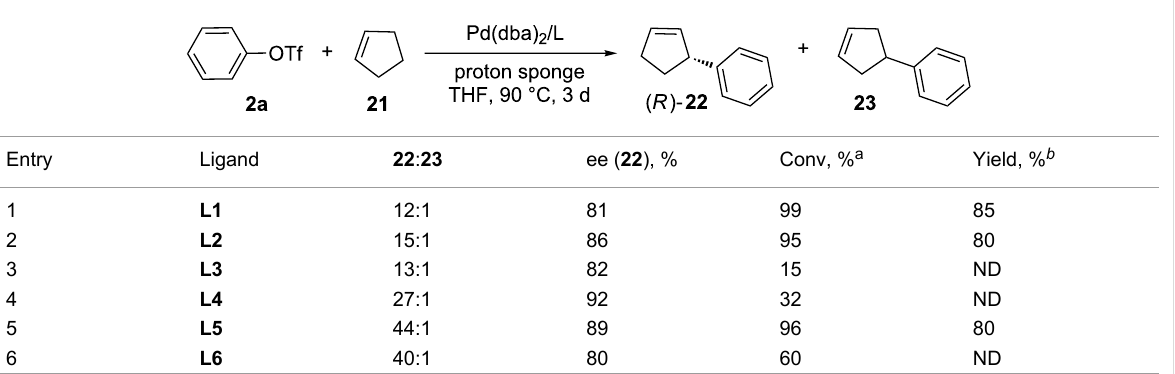
Table 5: Evaluation of Ligands L1 – L6 in the intermolecular asymmetric Heck reaction of phenyl triflate ( 2a ) with cyclopentene ( 19